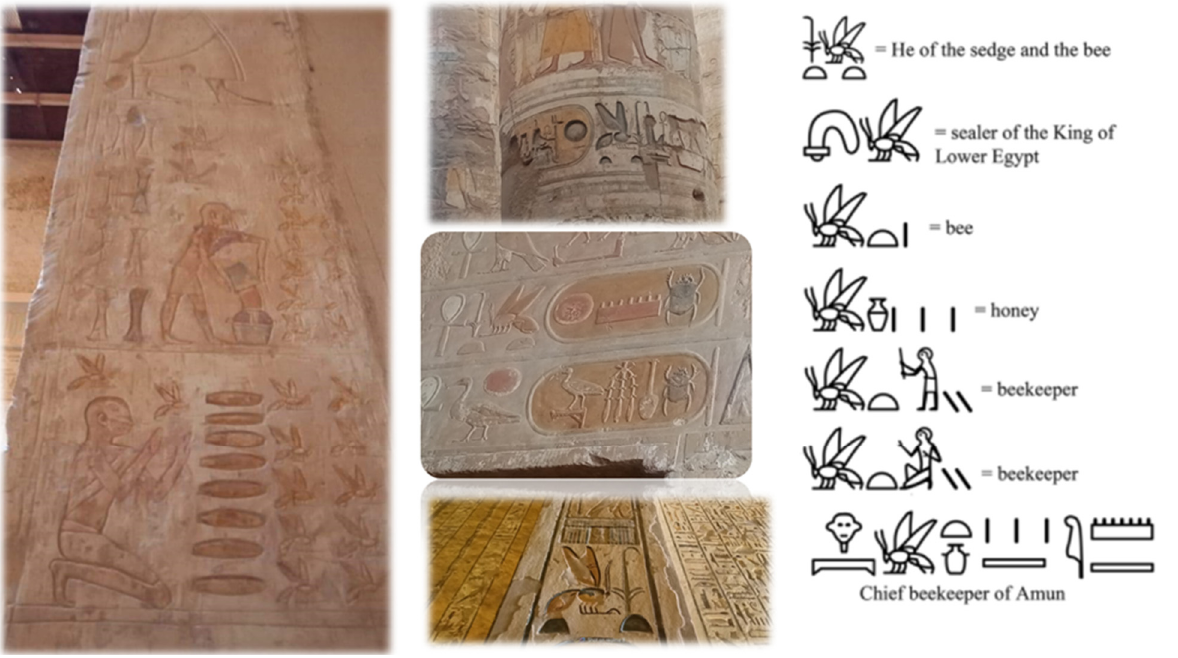
Figure 2. Beekeeping reliefs from the tomb of Pabasa and Karnak Temple (Photography by Aida Abd